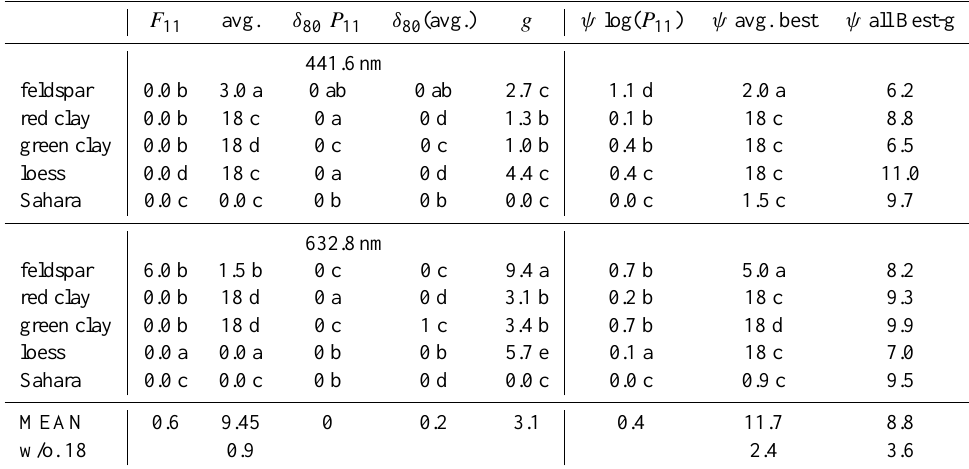
Table 3. The best-fit n values of ξ n shape distributions, Eq. (6), using different criteria. The refractive index with which the best-fit value was obtained is indicated by: a = 1 . 55 + 0 . 001 i ; b = 1 . 55 + 0 . 01 i ; c = 1 . 7 + 0 . 001 i ; d = 1 . 7 + 0 . 01 i . and e = 1 . 6 + 0 . 003 i . The last row shows the column averages when excluding the cases with n =